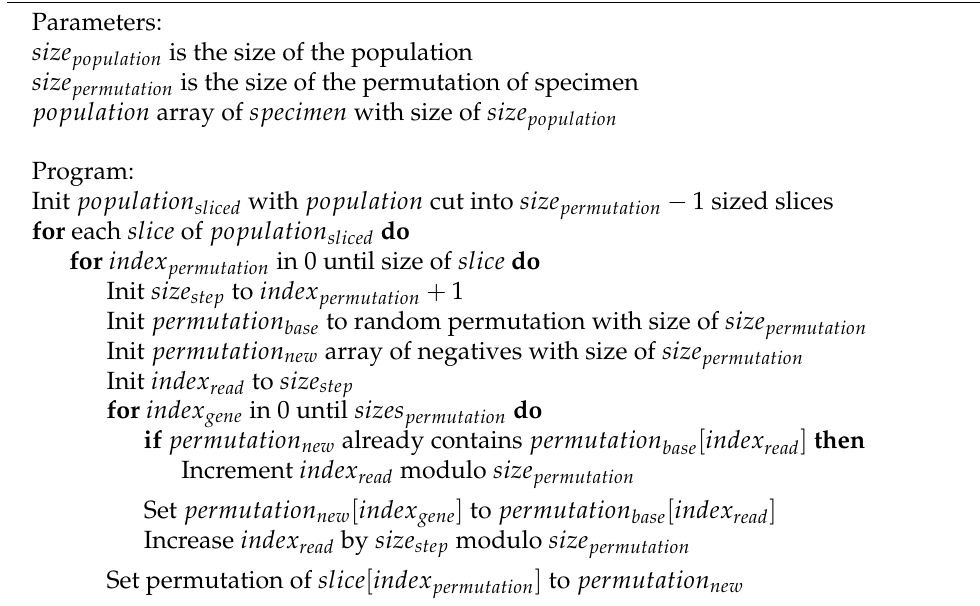
Algorithm 2 Modulo stepper